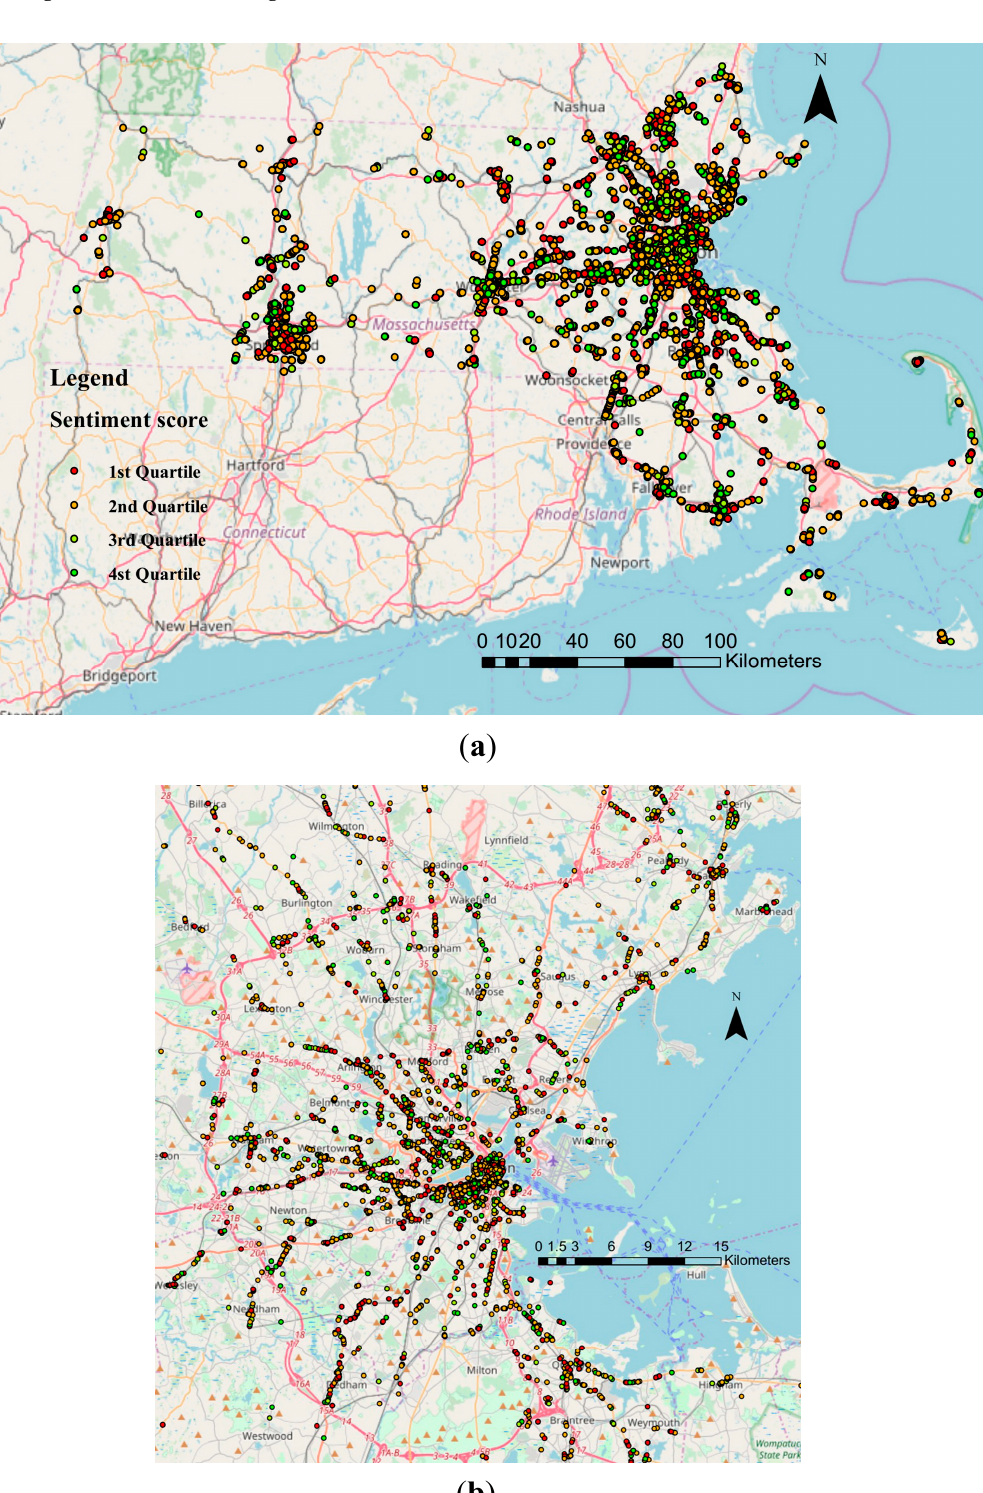
Figure 2. Geographical distribution of tweets with quartiles of sentiment scores in ( a ) Massachusetts and ( b ) Greater Boston area. First quartile ( − 1.000 to − 0.410), second quartile ( − 0.410 to 0.000), third quartile (0.000 to 0.514), and fourth quartile (0.514 to 1.000).